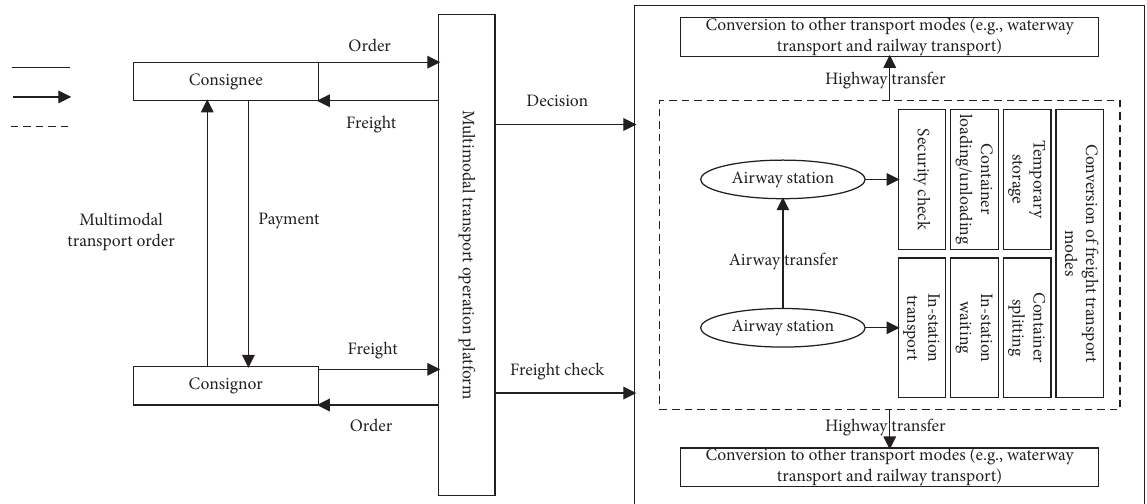
Figure 2: Organizational mode of multimodal freight transport.